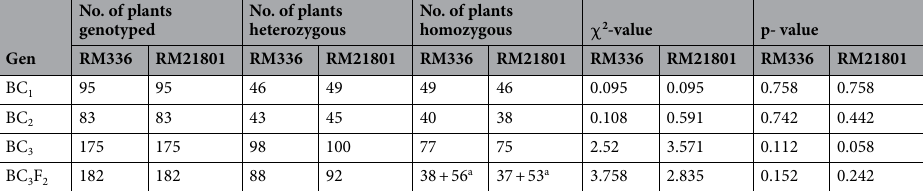
Table 2. Segregation analyses of tsv 1 linked markers in back cross generations. a 38 and 37 plants homozygous for tsv1 gene, 56 and 53 plants homozygous for recipient allele in BC 3 F 2 .